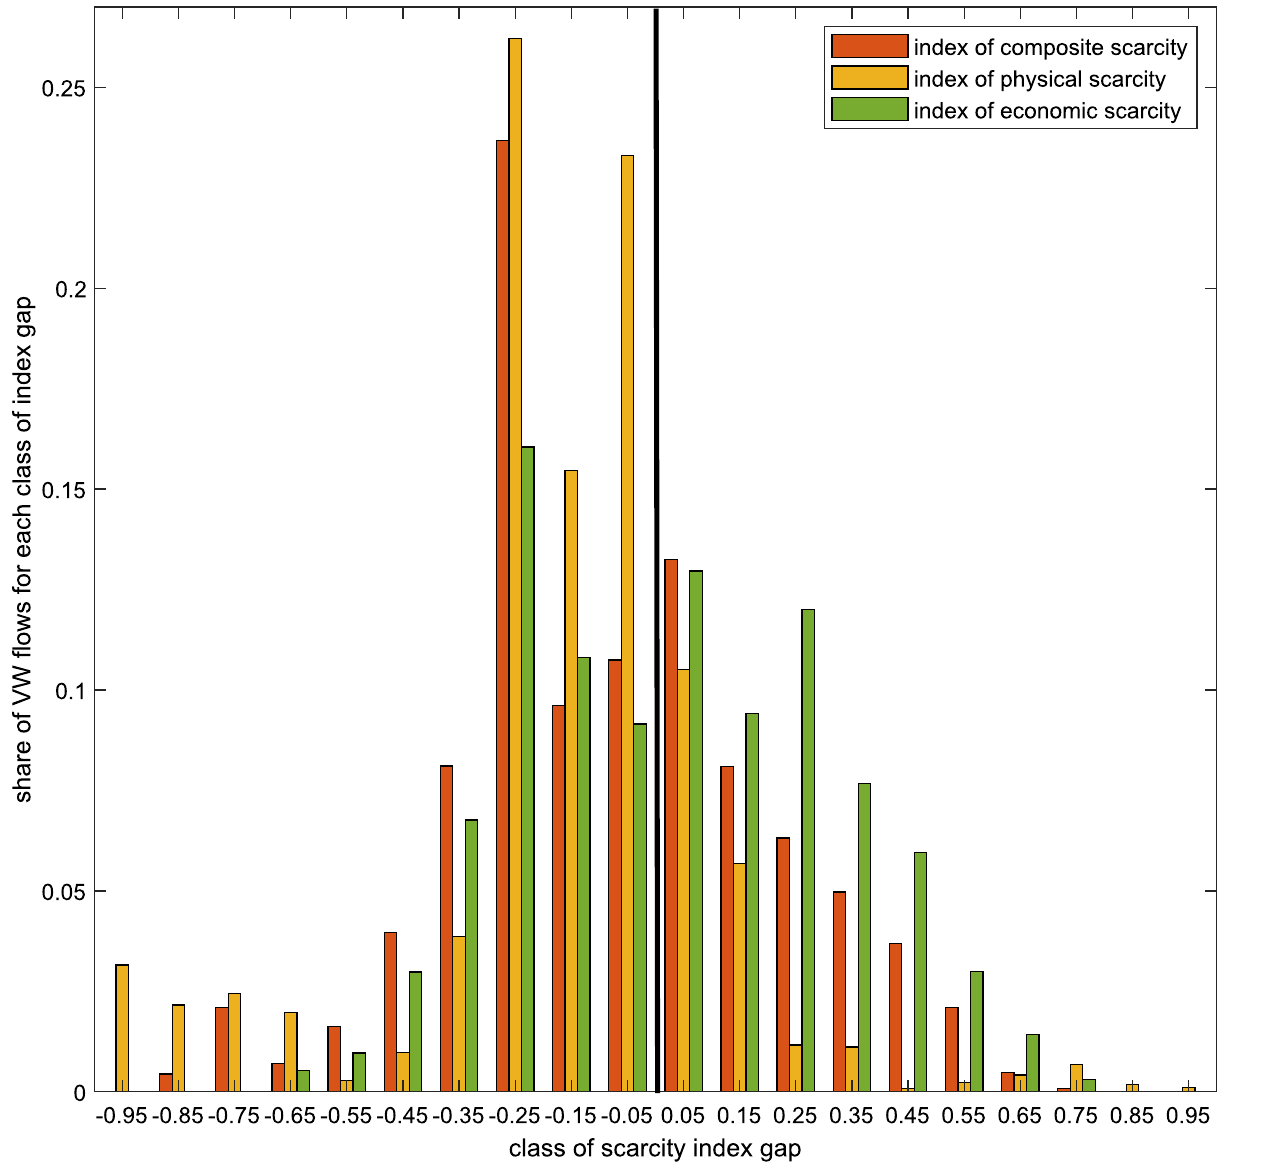
Figure 3. Share of VW fluxes for every class of scarcity index gap for all bilateral VW flows (2016). The gaps have been calculated for the composite scarcity index (CWSI, red bars), for the physical scarcity index (yellow bars), and for the economic scarcity index (green